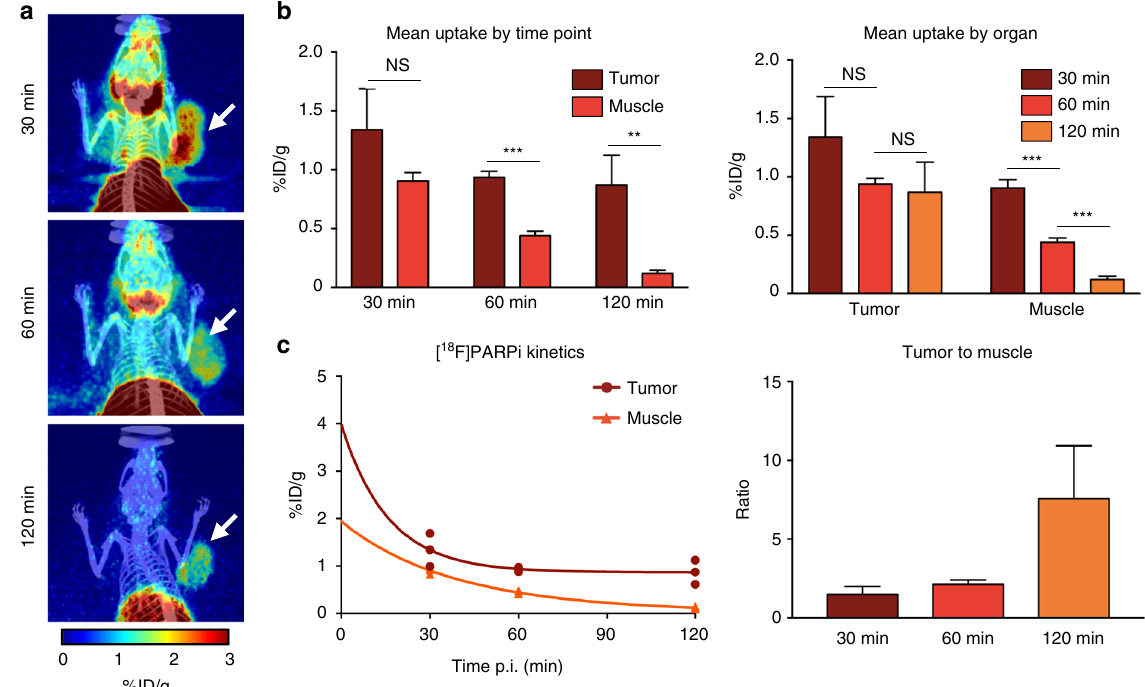
Fig. 4 In vivo kinetics of [ 18 F]PARPi. JHU-LX48 SCLC PDX bearing mice ( n = 3/group, 3 group, 9 mice total) were injected (i.v.) with 200 – 300 µ Ci of [ 18 F] PARPi and imaged via PET/CT at 30, 60, and 120 min post injection. a Representative MIPs from a single mouse at all 3 time points. b Quanti fi cation of PET images for tumor and muscle grouped by time point (left) and grouped by organ (right). c Two phase decay curve showing wash out of the tracer from the muscle as the activity in the tumor site remains relatively constant after 60 min (left) along with resulting tumor to muscle ratios (right). Non-parametric Student ’ s t -test was used to calculate the statistics. ** P < 0.01, *** P < 0.001. Error bars represent the